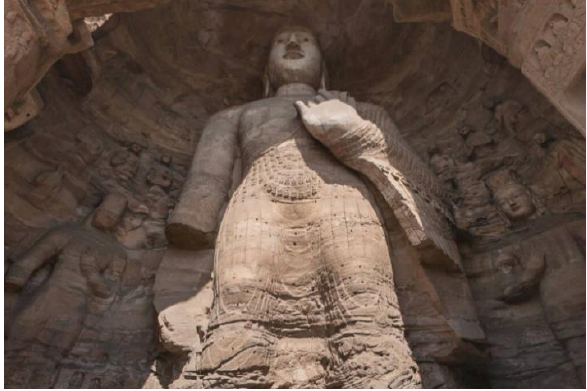
Figure 2. The 18th Cave of Yungang Grottoes